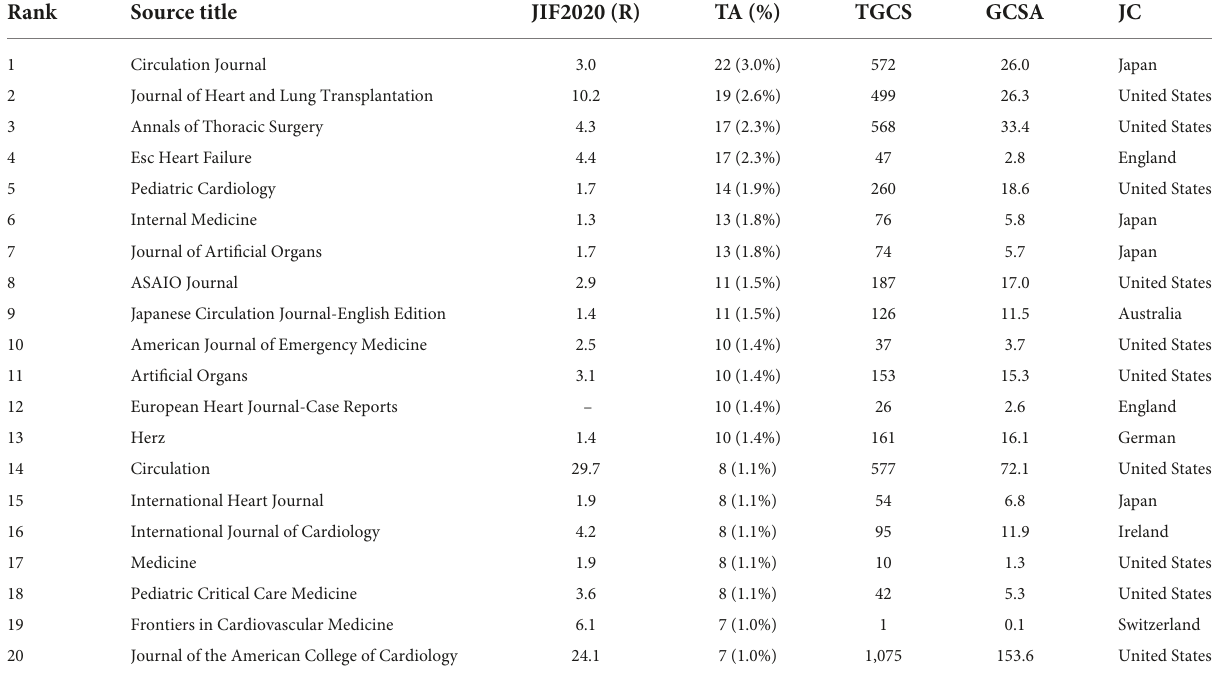
TABLE 1 Quantitative measurements of journals publishing documents concerning “fulminant myocarditis”